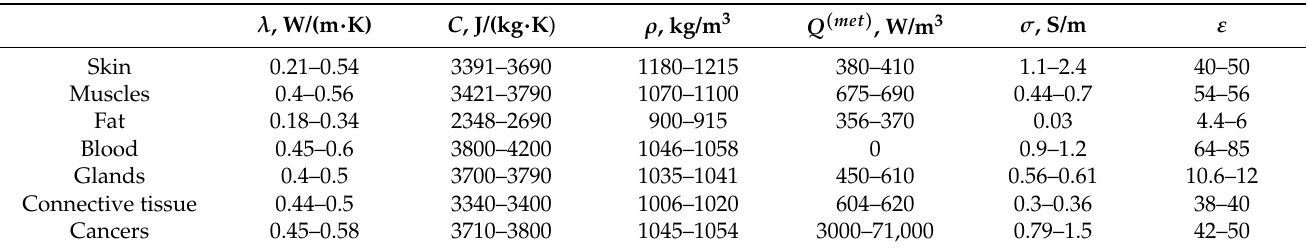
Table 1. The range of natural variability in the physical properties of the main components of the breast